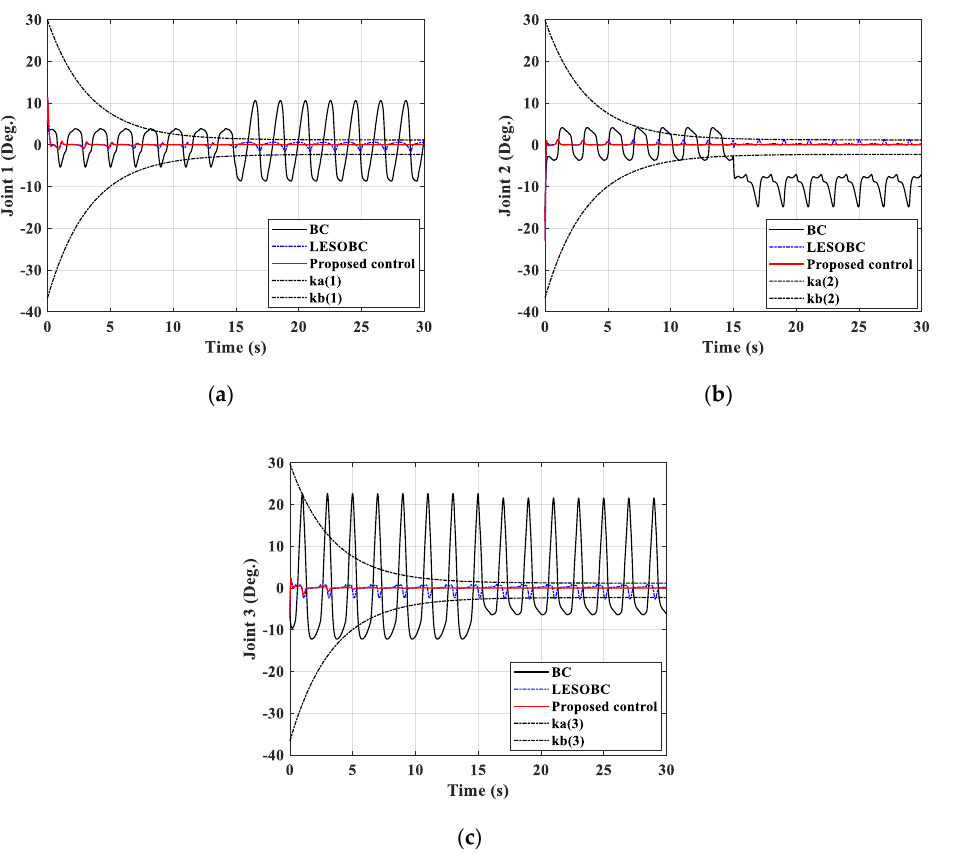
Figure 10. Error responses of three controllers in: ( a ) joint 1; ( b ) joint 2; and ( c ) joint 3 at 0.5 Hz.